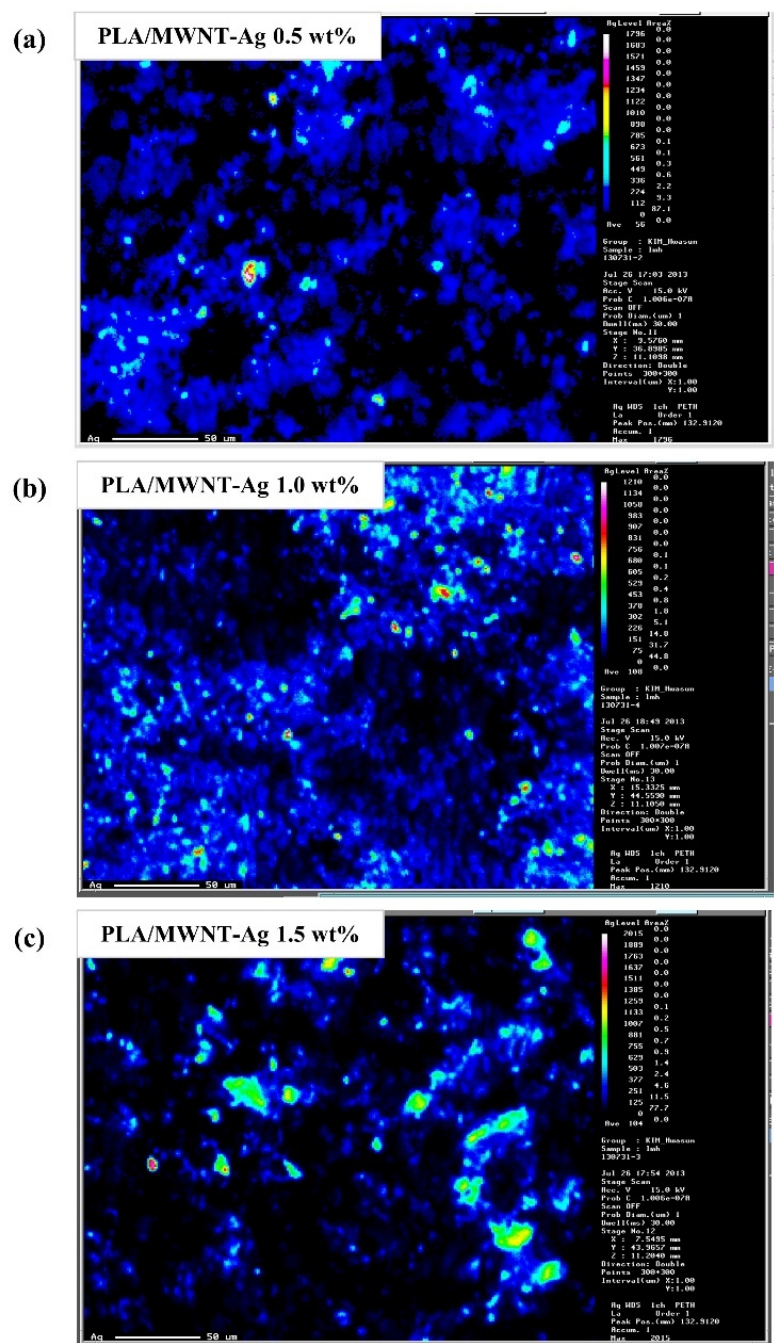
Figure 5. EPMA mapping images of PLA/MWNT-Ag films: ( a ) PLA/MWNT-Ag 0.5 wt%; ( b ) PLA/MWNT-Ag 1.0 wt%; and ( c ) PLA/MWNT-Ag 1.5 wt%. Quantitative analysis was conducted with the same samples in order to measure the degree of dispersion more precisely. In Figure 6, the black dot indicates the weight percentage of Ag added to the PLA matrix, while the red dot represents that of Ag measured by the EPMA equipment. The measured weight percentage of Ag is slightly lower than the added Ag weight percentage. The reason may be that there still exist some aggregation parts of MWNT-Ag after 24 h sonication. Additionally, the relatively wide range of standard deviations is due to more nanoparticle